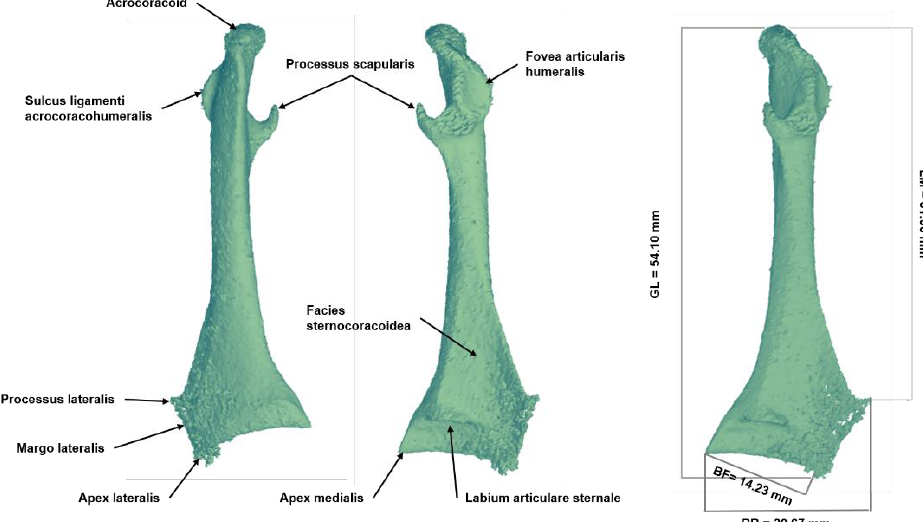
Figure 7. Three-dimensional reconstruction of the coracoid of the Ardea purpurea glacier mummy. BB; broad basal = 20.67 mm.